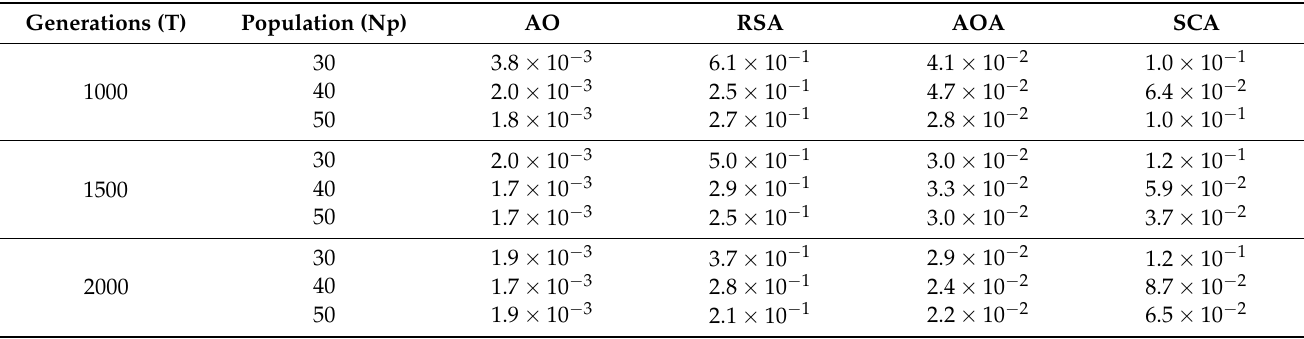
Table 18. Comparison of AO with RSA, SCA, and AOA against average fit for the CAR model at 0.04 noise variance.